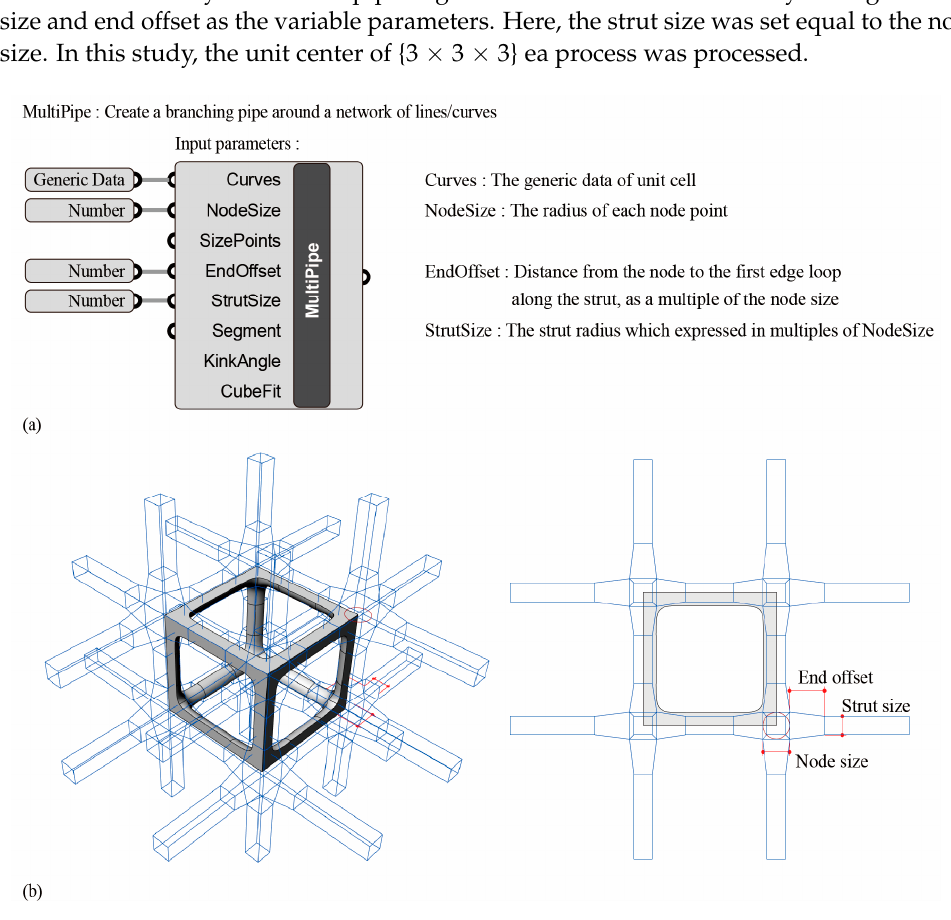
Figure 9. Multipipe function in Rhinoceros: ( a ) input parameters; ( b ) position of each variable parameter on the morphology control of the unit cell.